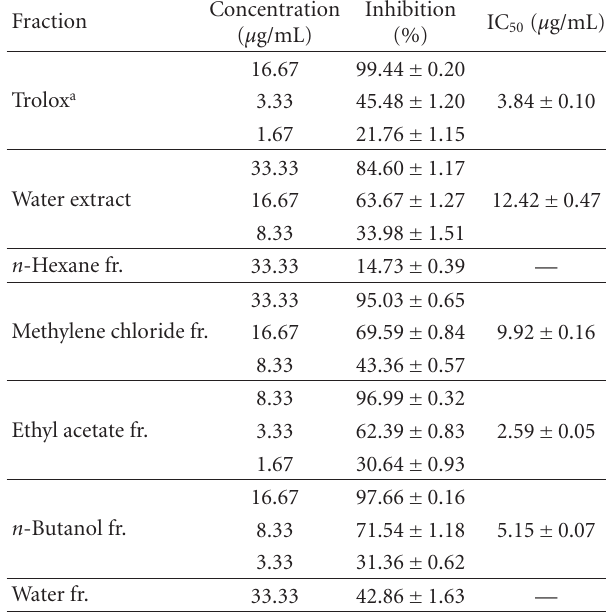
Table 6: Antioxidant e ff ects of the P. vulgaris L. on inhibition of the ABTS • +